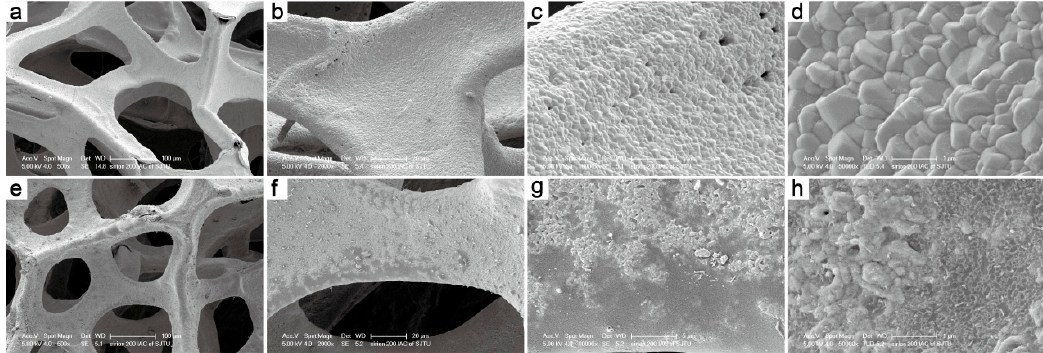
Figure 3. FESEM images of CuO foam before ( a–d ) and after ( e–h ) IPC reaction. (With magnification of 500 ( a, e ), 2000 ( b, f ), 10000 ( c, g ) and 50000 ( d, h )).